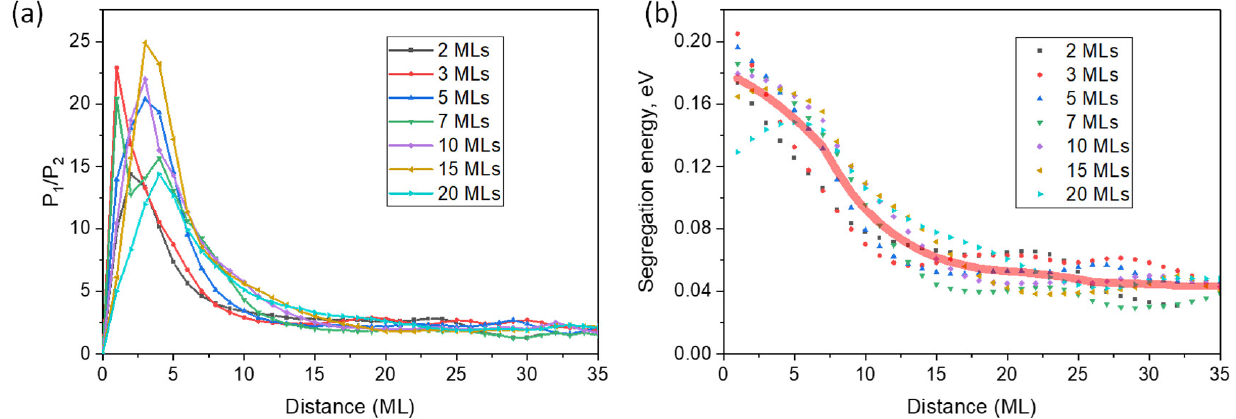
Figure 8. ( a ) The minimum of the exchange rate probabilities ratio and ( b ) the segregation energy during the growth. Steady state is reached in all periods after 15 MLs.